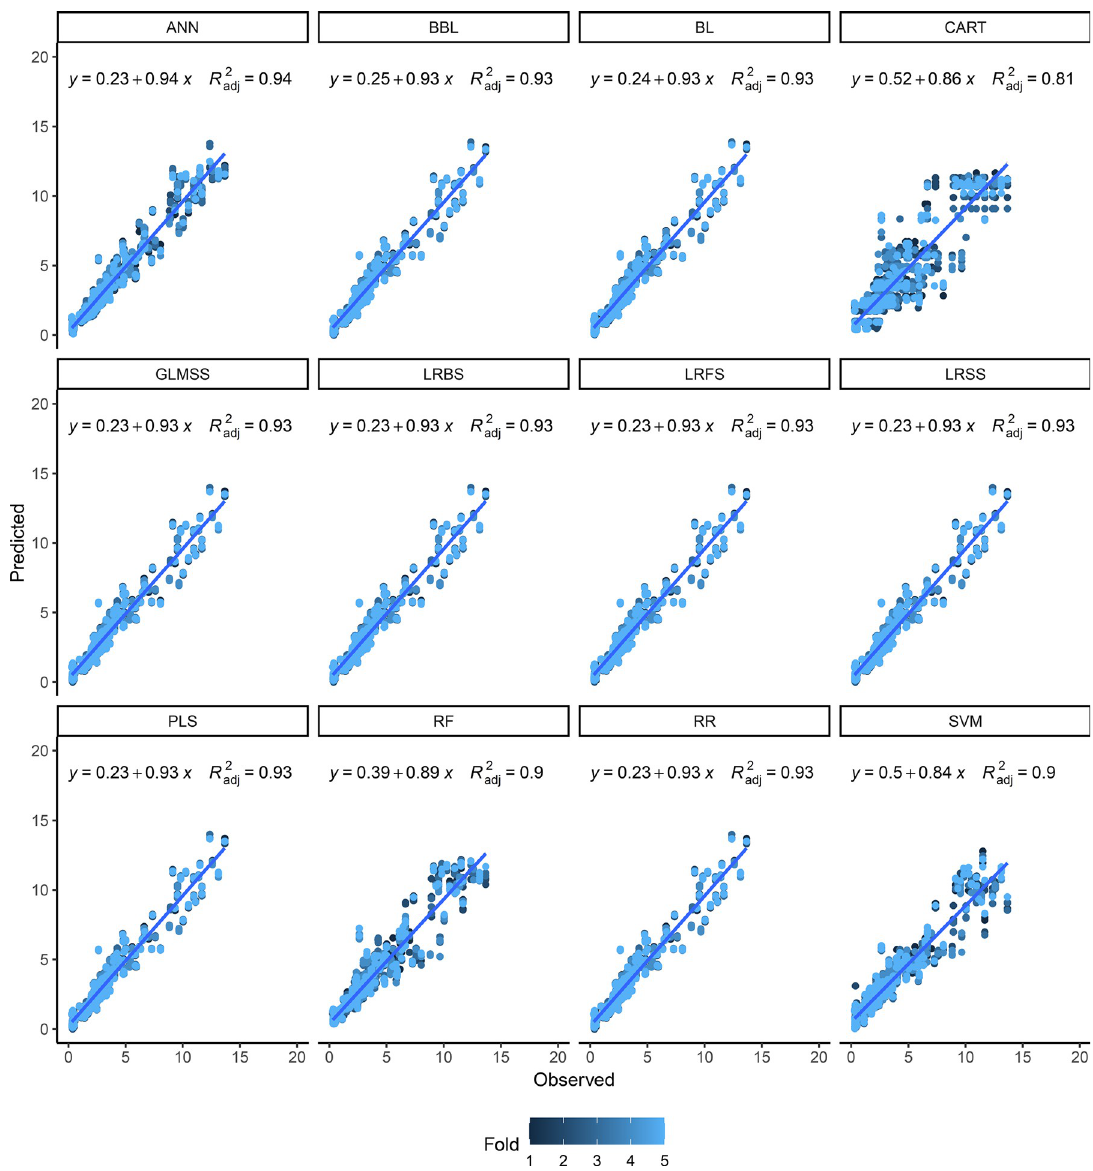
Fig 7. Relationship between observed and predicted values for total carotenoid content of cassava roots. The prediction was performed based on 12 different models based on random cross-validation with test set (IV-Random) (60/20/20% in training, validation, and test set respectively). Artificial neural network (ANN), Bayesian Blasso (BBL), Bayesian Lasso (BL), classification and regression trees (CART), generalized linear model with stepwise feature selection (GLMSS), linear regression with backward selection (LRBS), linear regression with forward selection (LRFS), linear regression with stepwise selection (LRSS), partial least squares (PLS), random forest (RF), ridge regression (RR), and Support vector machine (SVM) were calculated. Each cross-validation fold is represented in different colors. The numerical data included in the graphs represent: linear equations (y) and coefficient of determination (R 2 ).